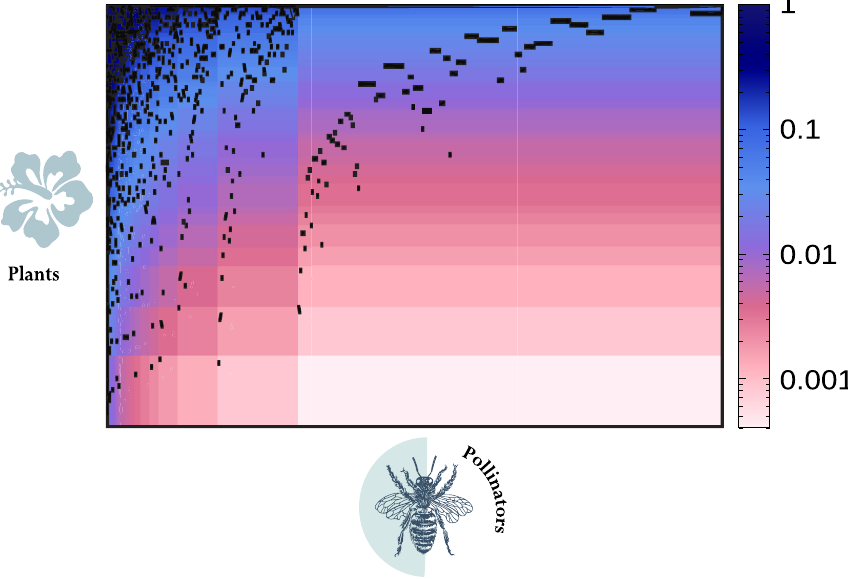
FIG. 2. Comparison between empirical mutualistic interactions and probability of interacting in the ensemble. The probability of interaction between species in the statistical ensemble given by h B (cid:2) i is shown as a color heat map for the plant-pollinator network recorded by Inoue et al. [46]. The empirical corresponding bipartite matrix of interactions B (cid:2) is superimposed in black. Both plant and pollinator species are ordered in decreasing order of their degrees (from top to bottom and from left to right). As it can be seen at a glance, the obtained probabilities are consistent with the observed interactions, with the dark regions delimiting an upper left triangle, as in an ideally nested structure. Note that the color legend is in logarithmic